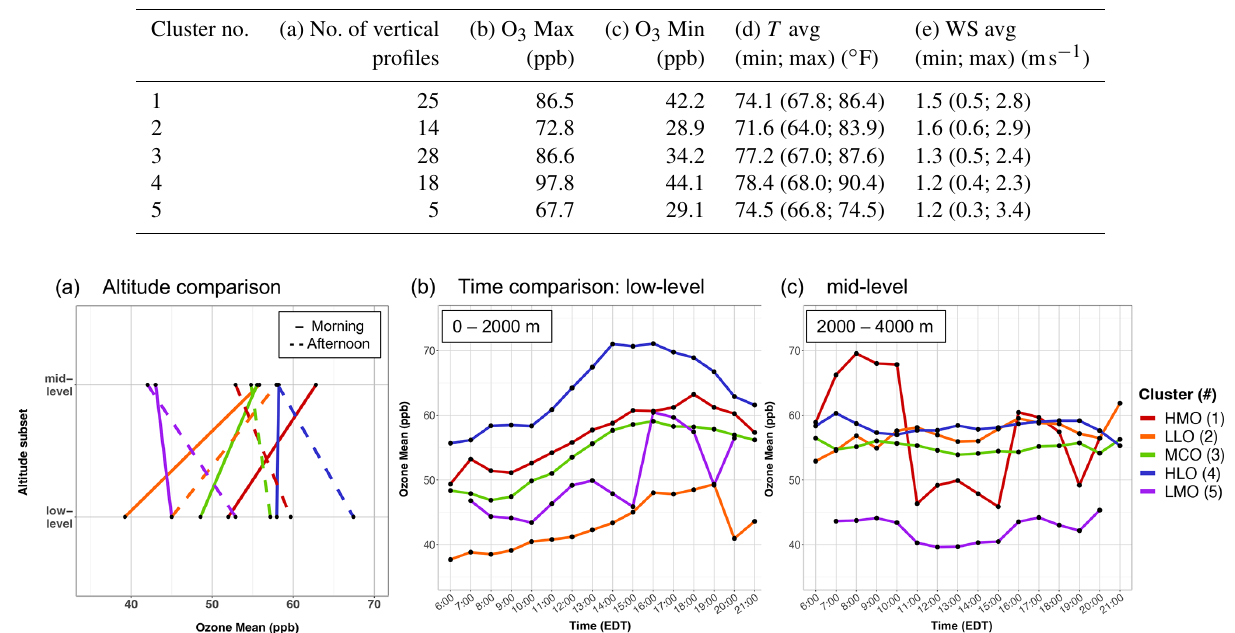
Table 1. Lidar vertical O 3 profile cluster statistics: (a) total number of vertical profiles; (b) O 3 maximum; (c) O 3 minimum. AQS monitoring station cluster mean (d) surface temperature and (e) wind speed (WS); minimum and maximums in parentheses. The statistics and averages were derived from the total number of profile curtains assigned to each cluster.